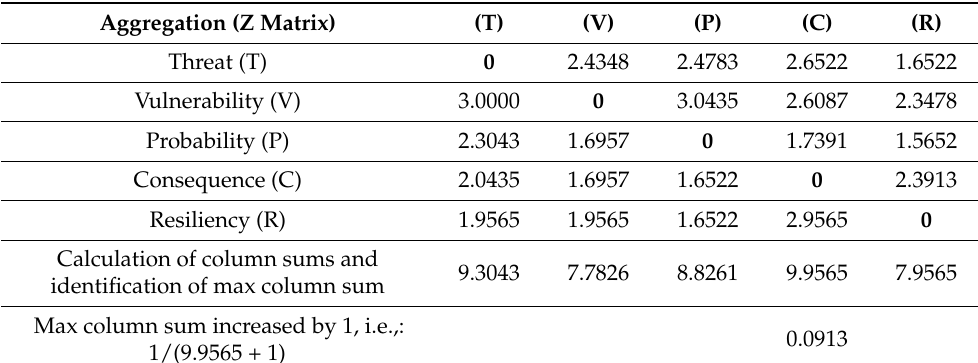
Table A1. Aggregation of inputs received from IT security experts.